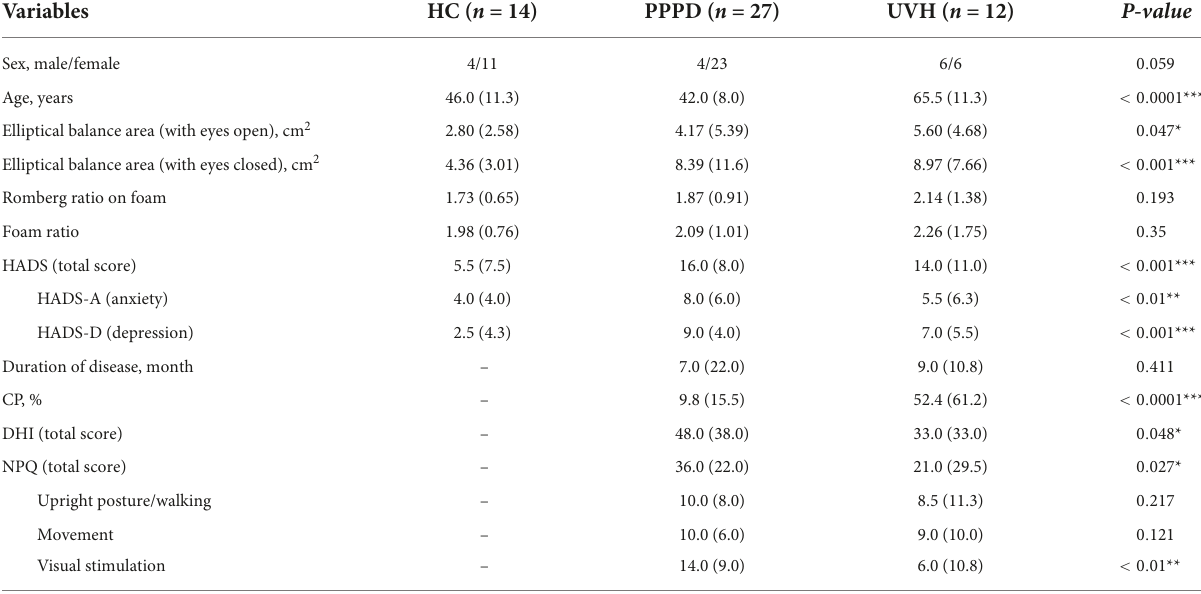
TABLE 1 Clinical and demographic characteristics of those in the healthy control, persistent postural-perceptual dizziness, and unilateral vestibular hypofunction groups. Variables